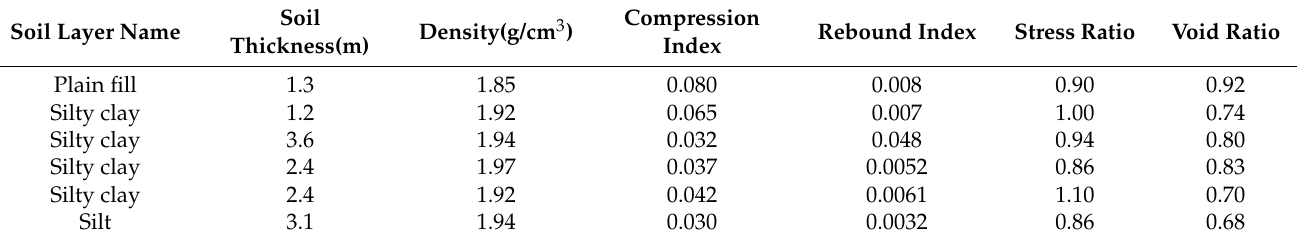
Table 1. The physical and mechanical parameters of the soil layer.